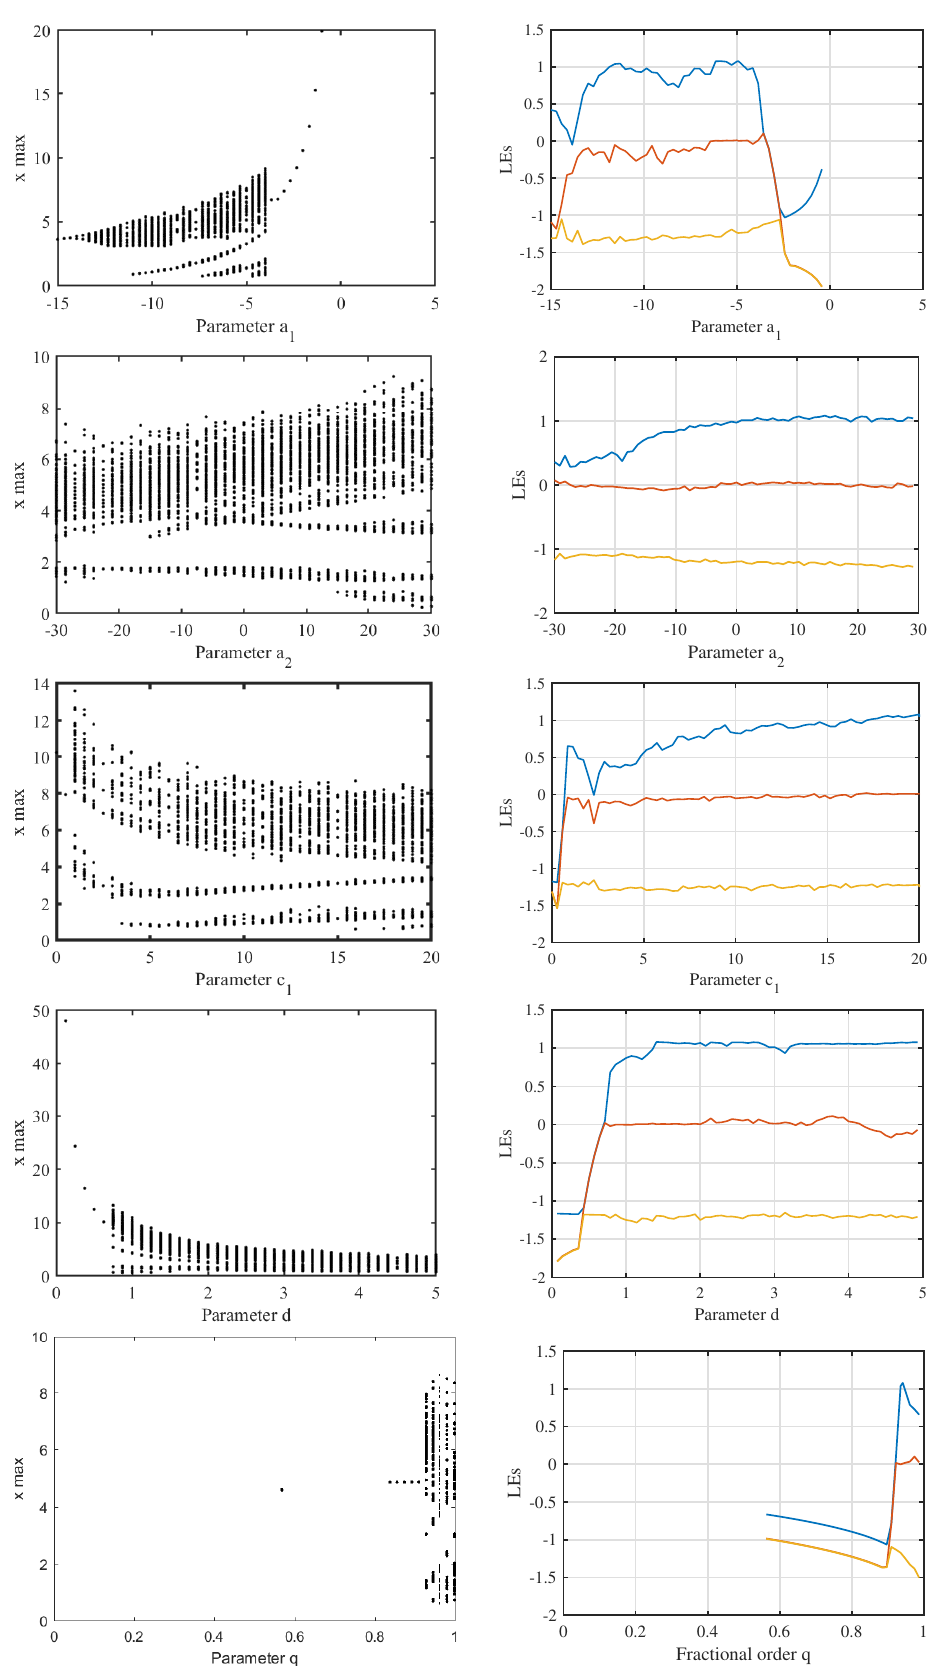
Figure 6. Bifurcation diagrams and Lyapunov exponents spectra of the optimized fractional-order system (2), using parameters a 1 , a 2 , c 1 , d and fractional-order q , for the DE-optimized